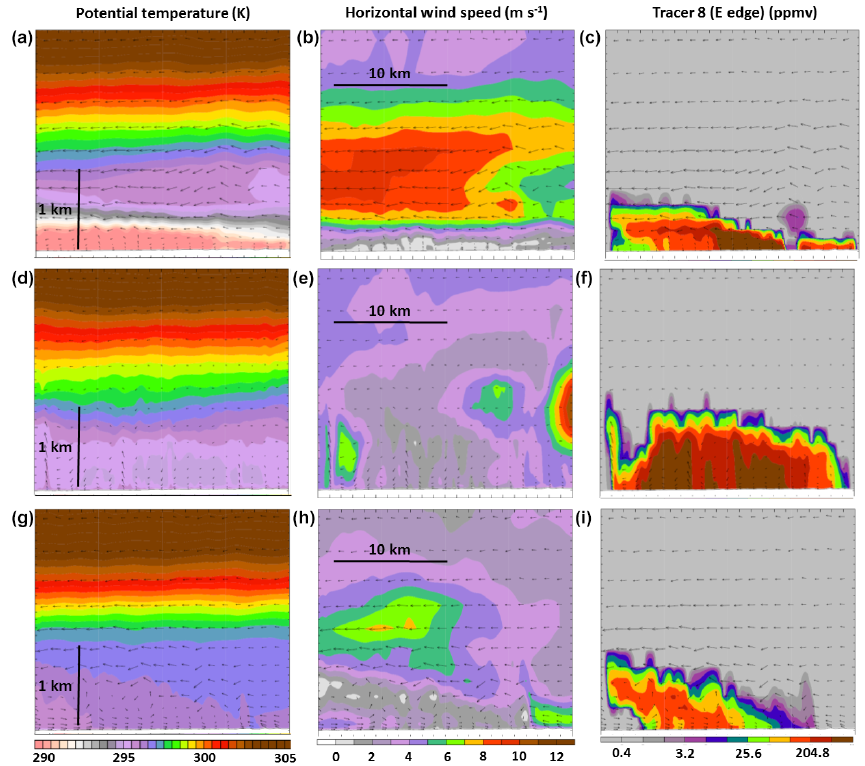
Figure 8. Vertical transects across the 111m west–east WRF-LES simulation domain (pixels 5, 6, 7, and 8) at 18:00UTC of 15 January (a–c) , 21:00UTC (d–f) , and 00:00UTC (g–i) . From left to right, simulated data are shown for potential temperature (in K, a, d, g ), mean horizontal wind speed and direction (inms − 1 and degree, (b, e, h ), and passive tracer concentration released from an eastern pixel of the emitting area (pixel 5, c, f, i ), to illustrate the relationship between the three variables.